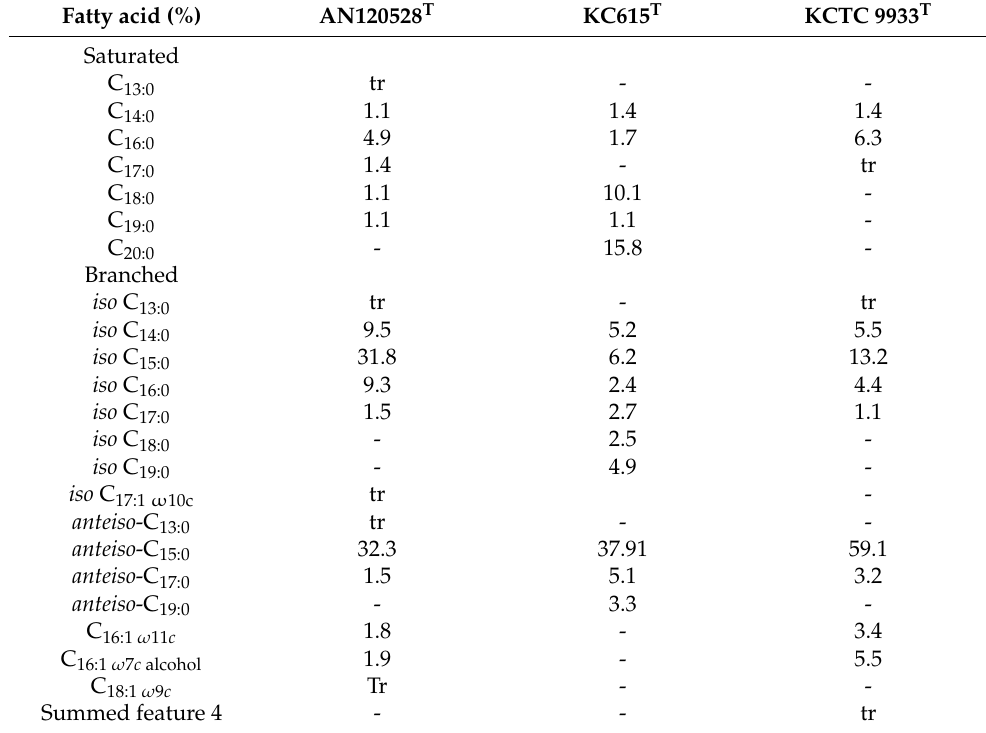
Table 2. Fatty acid compositions of strain AN120528 T and another related